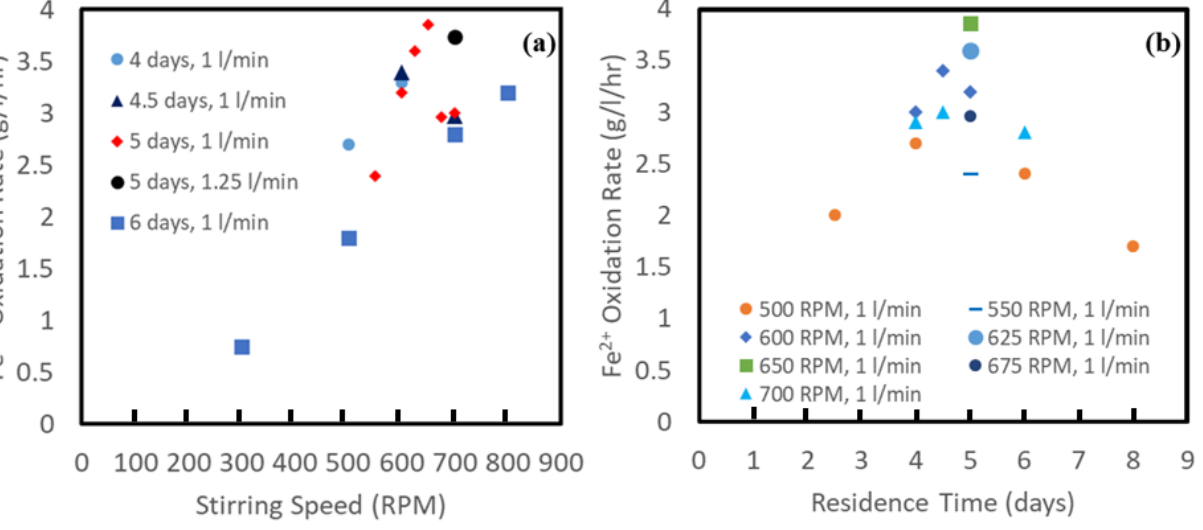
Figure 8. Detailed, more comprehensive comparison of: ( a ) stirring speed and ferrous ion oxidation rate; ( b ) residence time and ferrous ion oxidation rate.